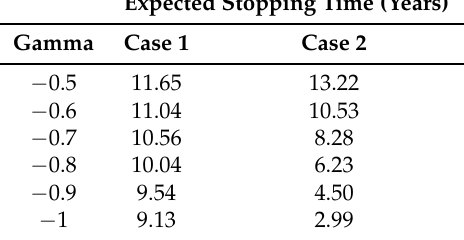
Table 2. Expected stopping times by level of risk aversion for case 1 and case 2 agents aged 65, in the healthy state, and with total wealth of 10 Y —and other parameters as given in Table 1. Increasing levels of risk aversion lead to falling stopping times. Also, the bequest motives of case 2 agents produce results much more sensitive to the level of risk aversion. Indeed, at γ = − 0.5 case 2 agents abandon their conservative behaviour and embrace the risky investment environment.